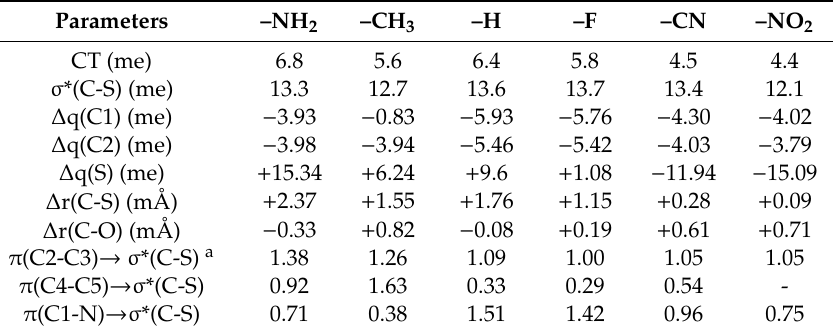
Table 9. NBO results of C complexes between para -substituted pyridine and OCS. Parameters